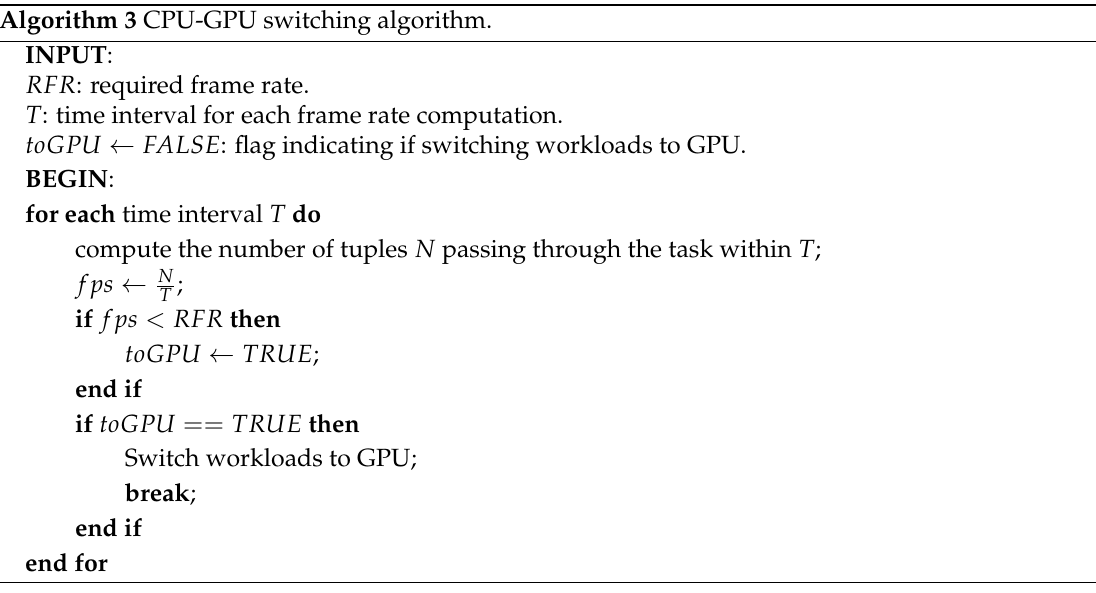
Algorithm 3 CPU-GPU switching algorithm.